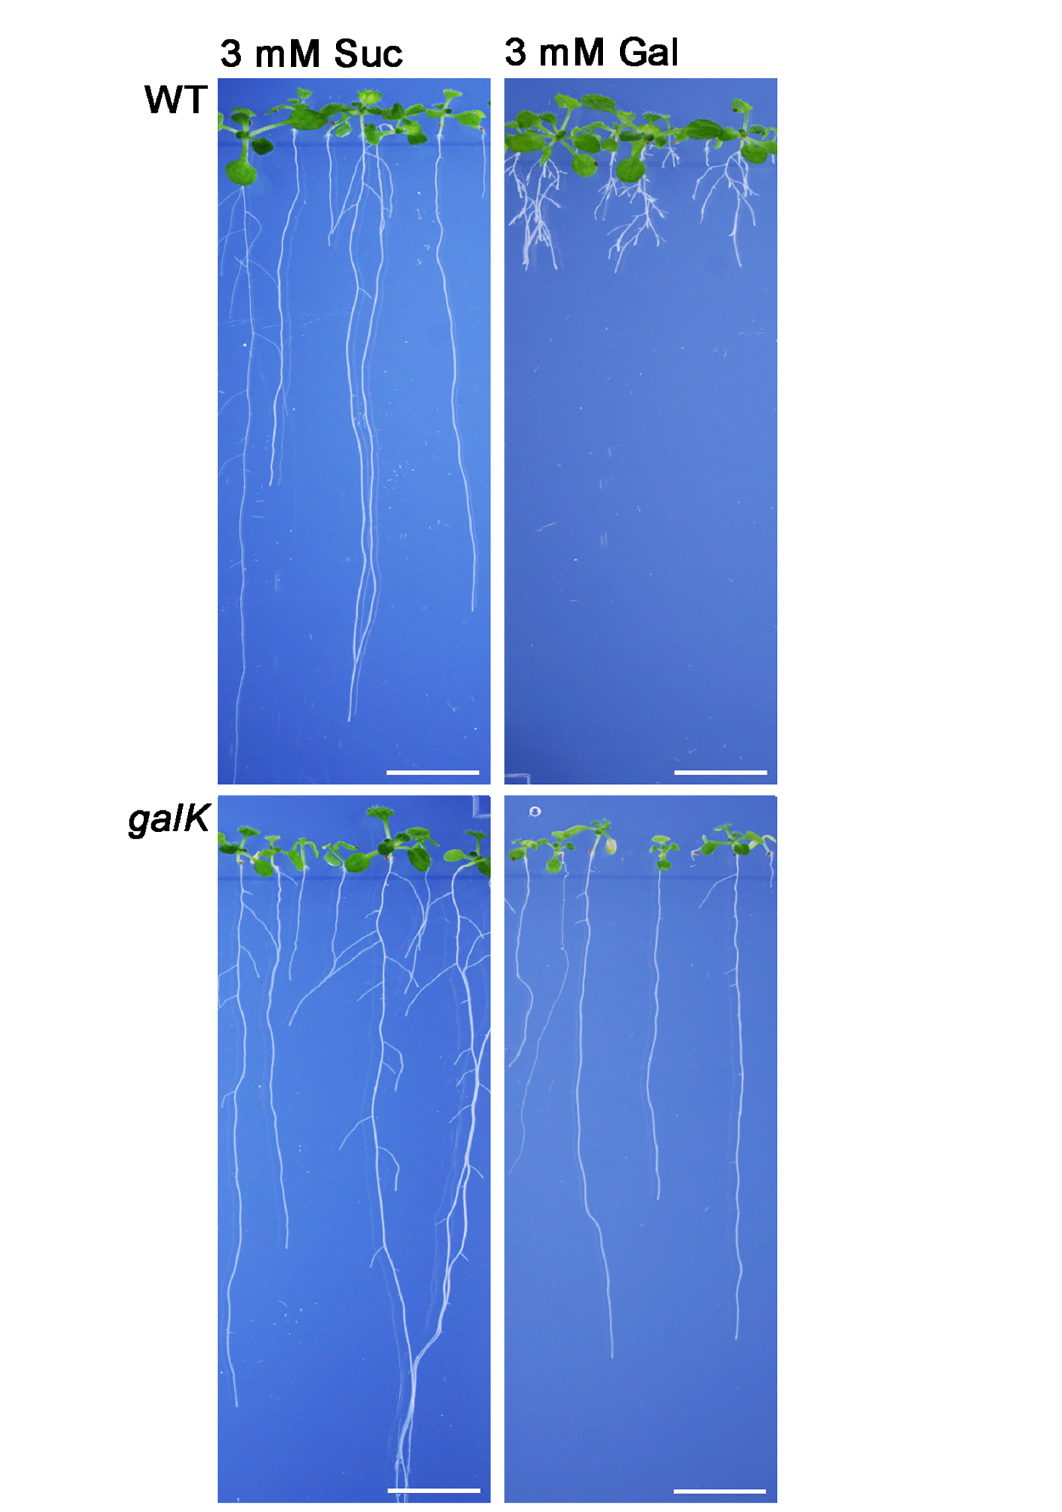
FIGURE 1 | Phenotype of Arabidopsis seedlings on 0.5× MS plates grown for 2 weeks with either 3 mM sucrose (left) or 3 mM galactose (right). WT plants show a severe change in root morphology on plates with galactose. The WT phenotype could be rescued by knocking out the galactokinase gene ( galK) indicating that galactokinase activity is required for Gal toxicity phenotype. Scale bars: 1